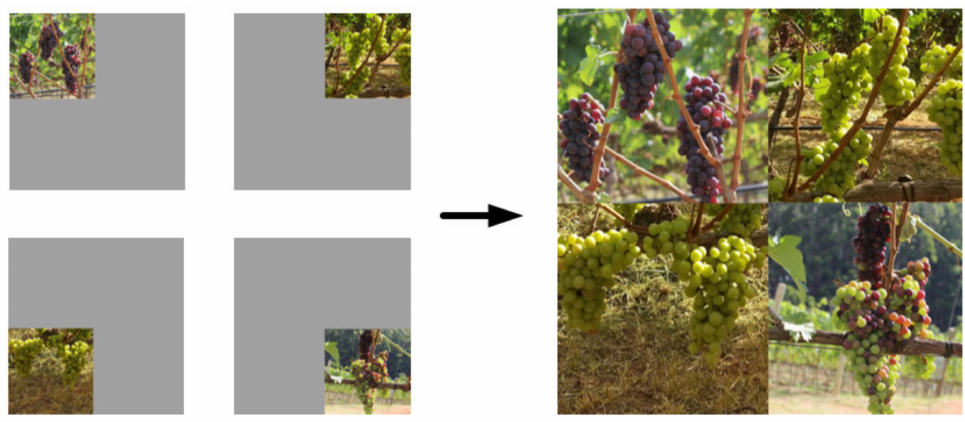
Figure 3. Mosaic data